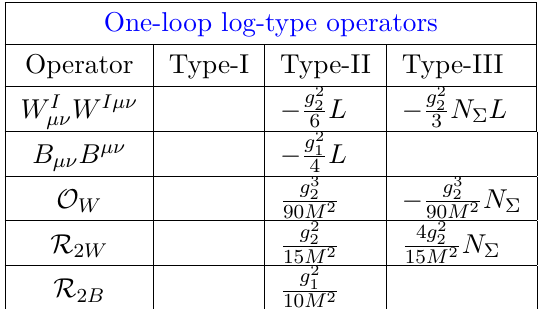
Figure 4 . The diagrams that contributes to effective operators R 0 respectively. The dual tensors in the effective operators can originate from the gamma matrices and covariant derivatives in the fermionic propagators in the CDE method. See the text for details.